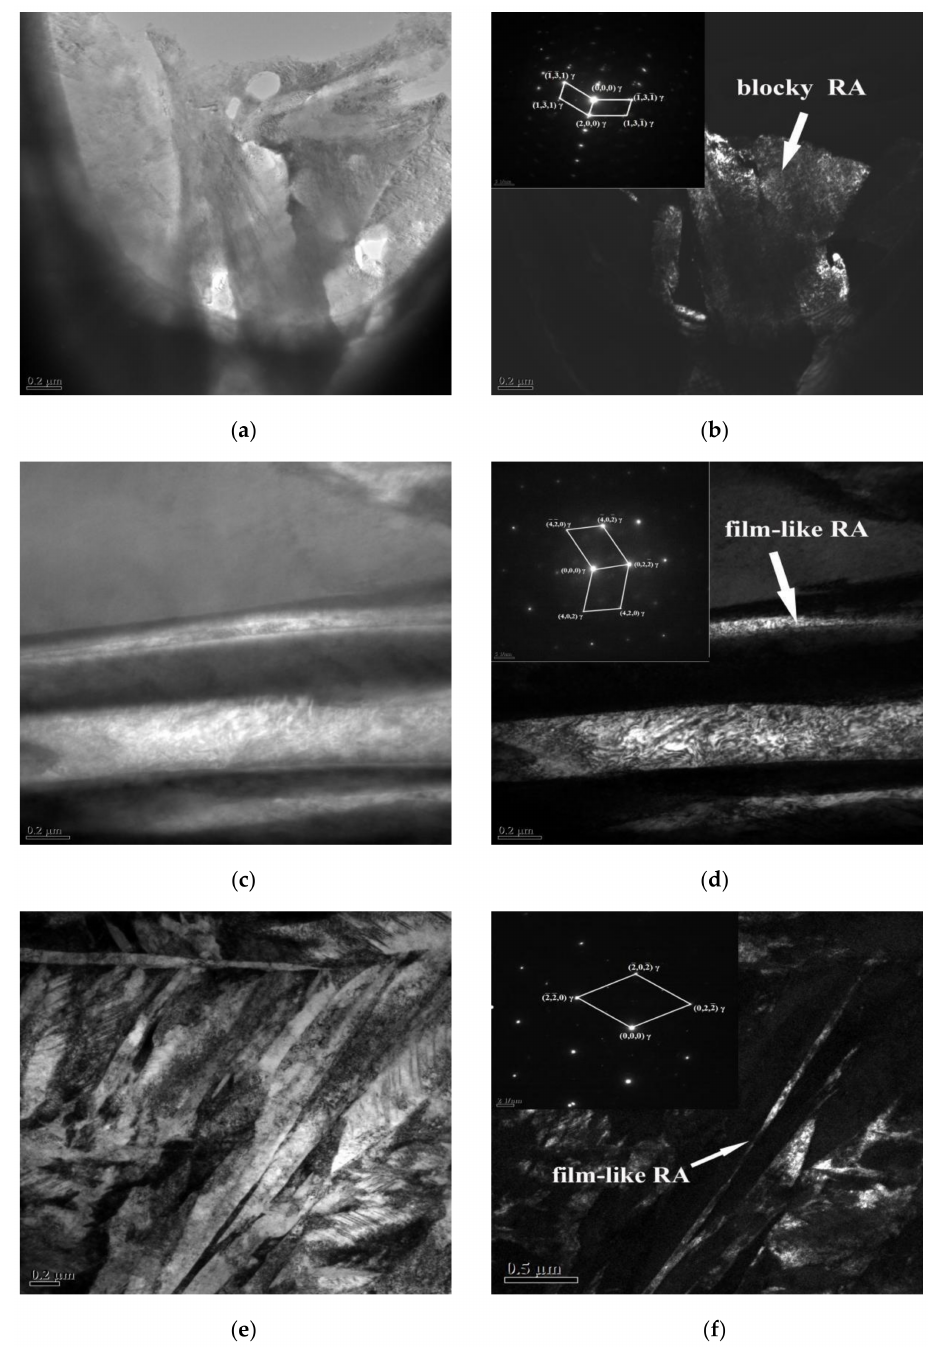
Figure 9. The TEM morphology of samples: ( a , b ) as-cast, ( c , d ) tq = 90 s, and ( e , f ) tq = 120